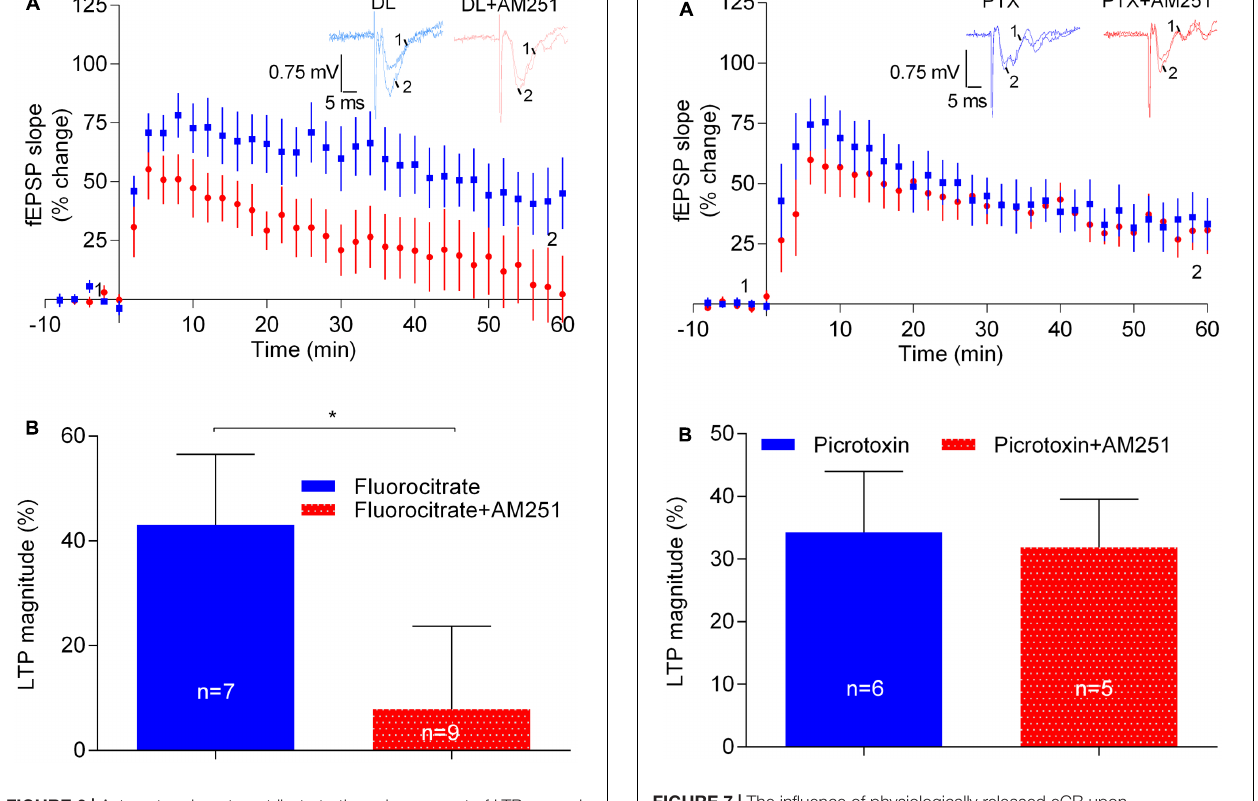
FIGURE 6 | Astrocytes do not contribute to the enhancement of LTP caused by physiologically released eCBs. (A) Data obtained in slices treated with 200 µ M Fluorocitrate to inhibit astrocyte metabolism, either in the absence (control) or in the presence of 1 µ M of AM251. (B) Quantification of LTP magnitude under the indicated conditions. In all cases, LTP was induced by a strong- θ -burst. ∗ p < 0.05 ( F ( 8 , 6 ) = 1.9, Student’s t -test). For further details see legend to Figure 1 .